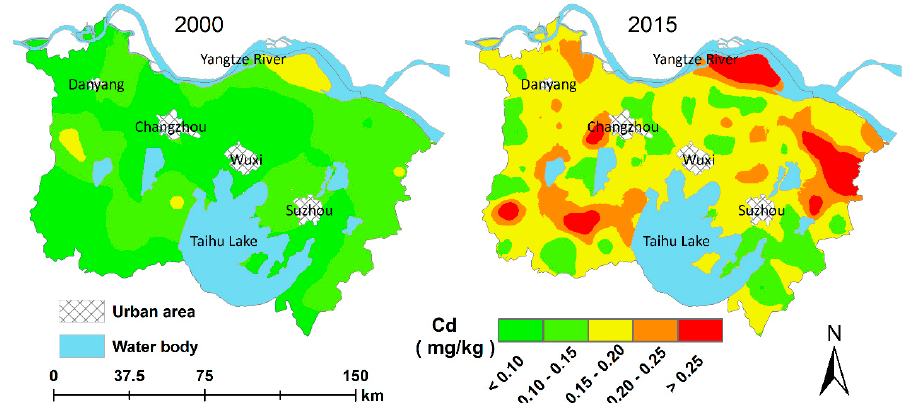
Figure 4. Ordinary kriging predicted spatial distribution maps of soil Cd (Cadmium) in 2000 and 2015.